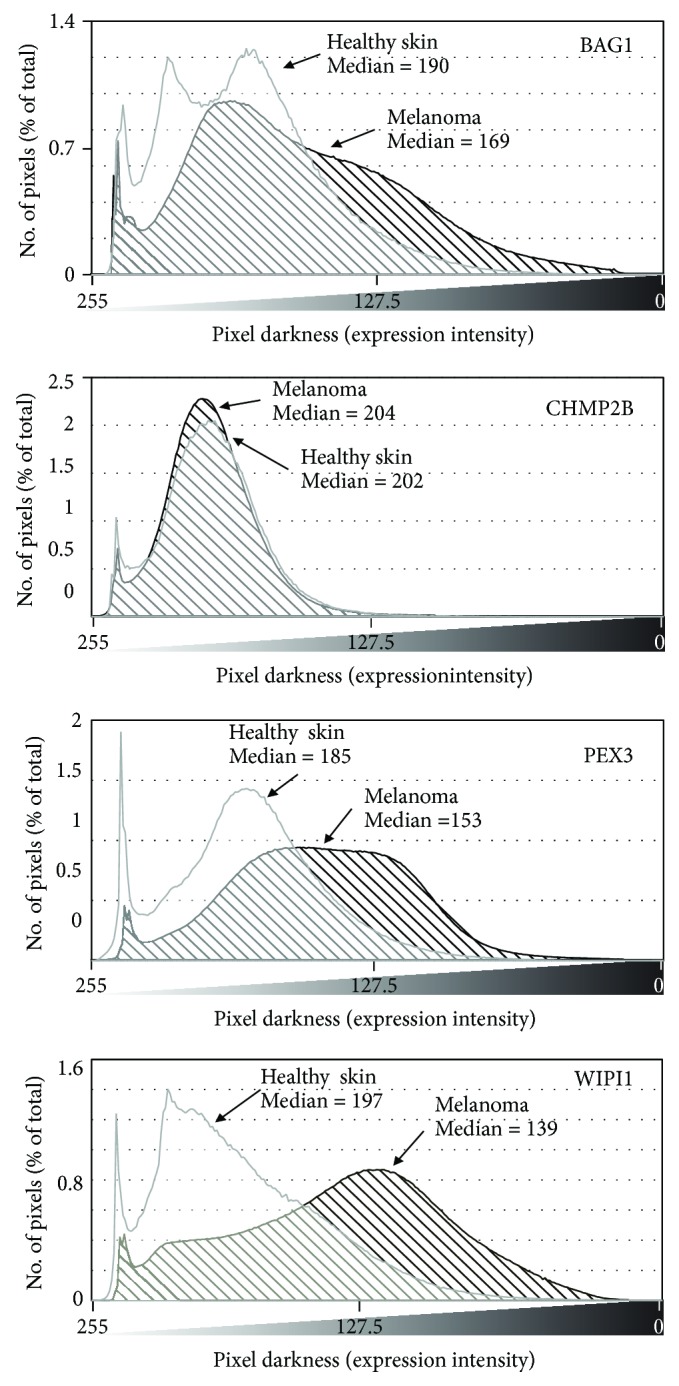
Protein expression according to the Human Protein Atlas. The plot reports the distribution of pixel as function of the expression level. Positions at the right end of the graph indicate higher protein expression. Median level in melanoma samples (dashed curve) shows a clear right shift as compared to healthy skin (gray curve), for BAG1, PEX3, and WIPI1 proteins.